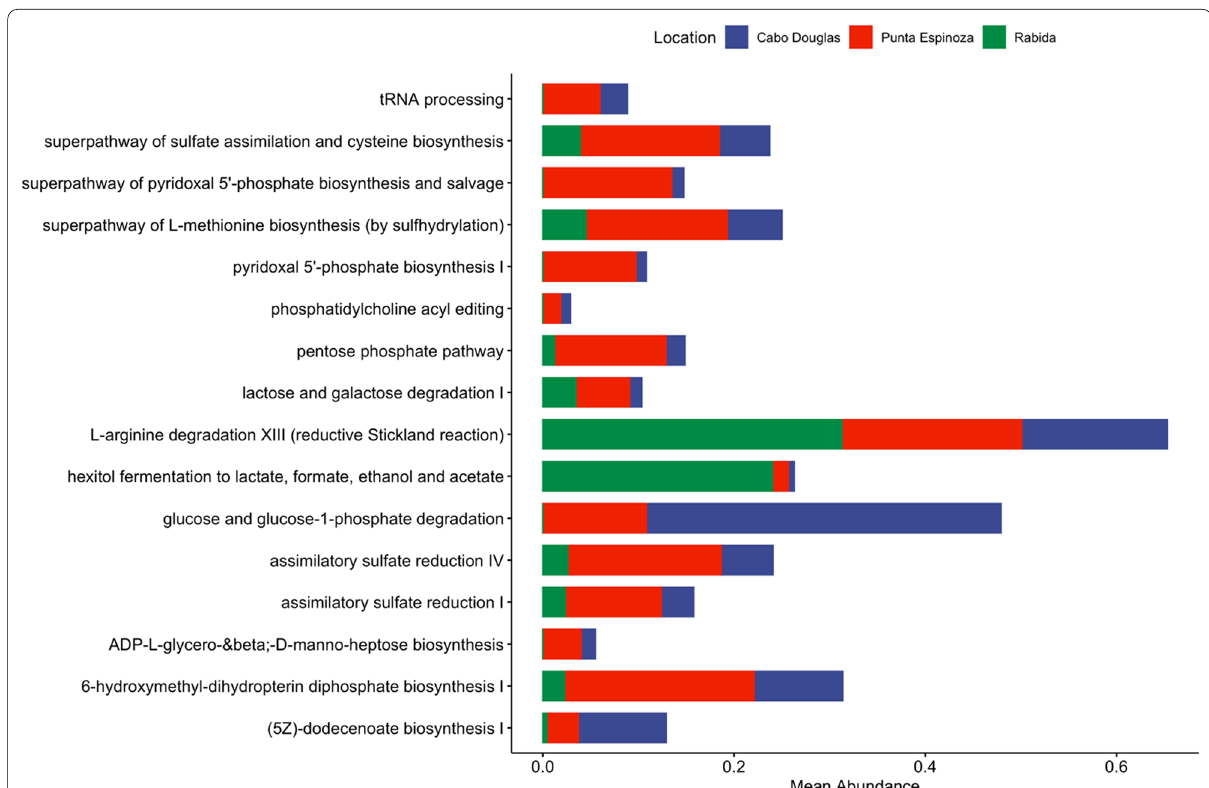
Fig. 5 Differentially abundant metabolic pathways of the marine iguana’s gut from three different locations. Abundance is shown as the average relative